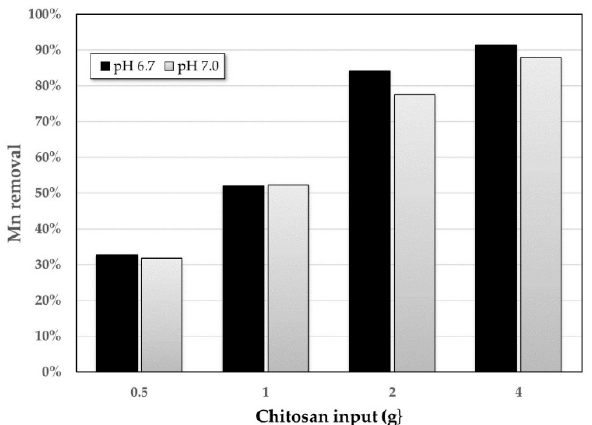
Figure 5. E ff ect of input amounts of chitosan on Mn removal from the simulated solutions at pH 6.7 and 7.